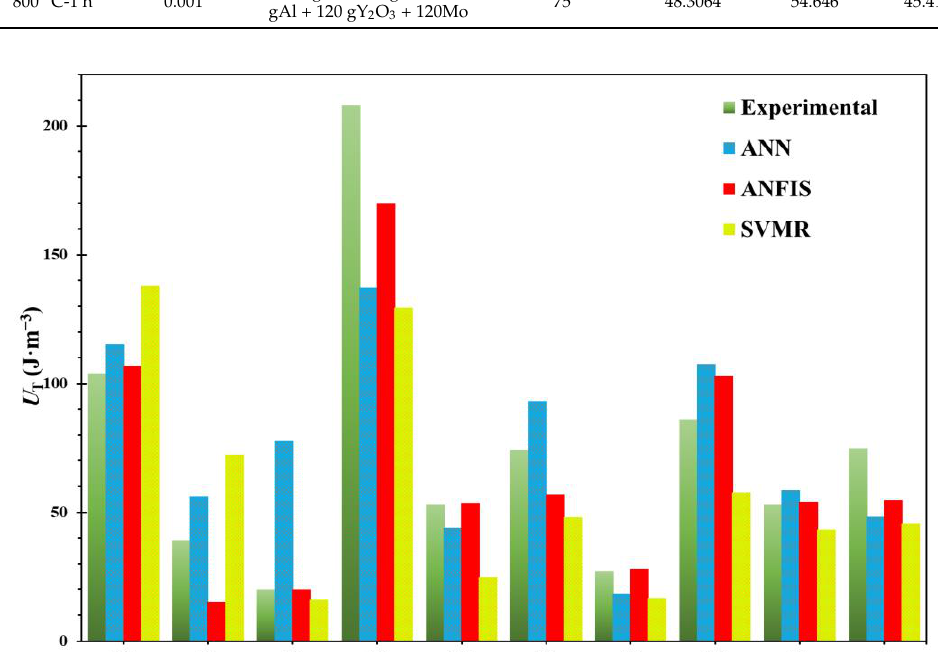
Table 5, these ten datasets (e.g., T1 to T10) were reported. Figure 5 and Table 5 illustrate